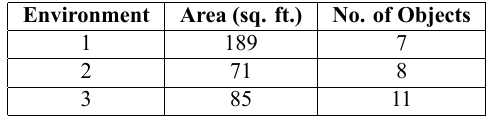
Table 1: The area and number of required objects for each of the environments used in the